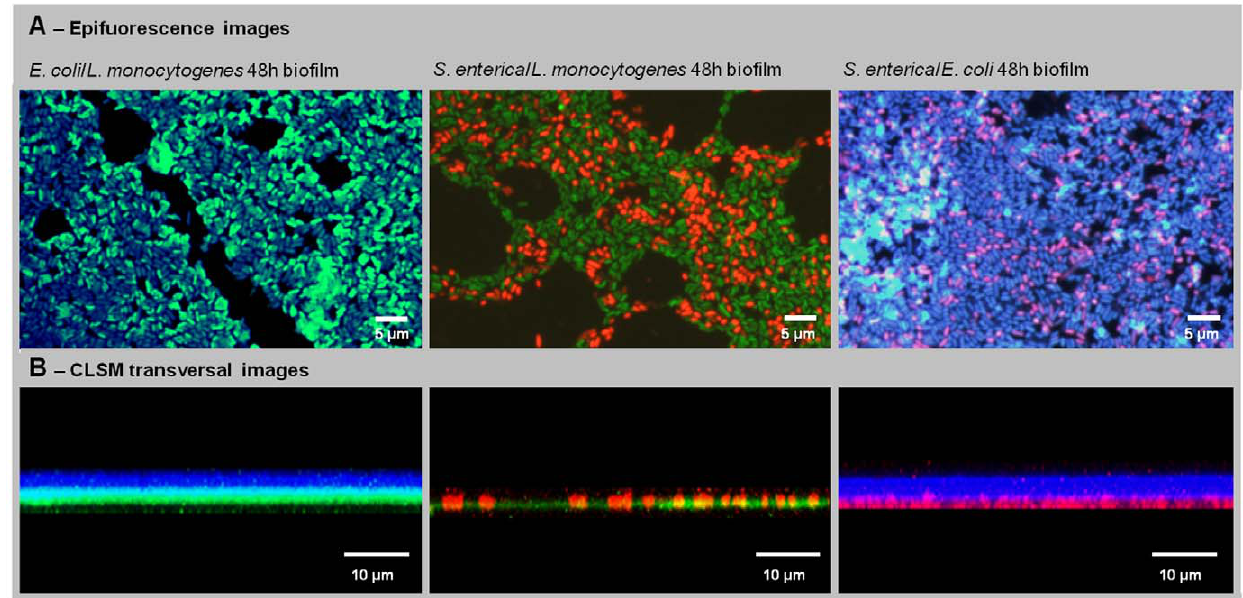
Figure 5. Dual-species biofilms spatial organization for 48 h. (A) Epifluorescence images showing an homogeneous distribution of the species. (B) CLSM transversal images showing that dual-species biofilms with E. coli presented two well defined layers. For Salmonella / Listeria biofim, it was not observed the formation of two layers.